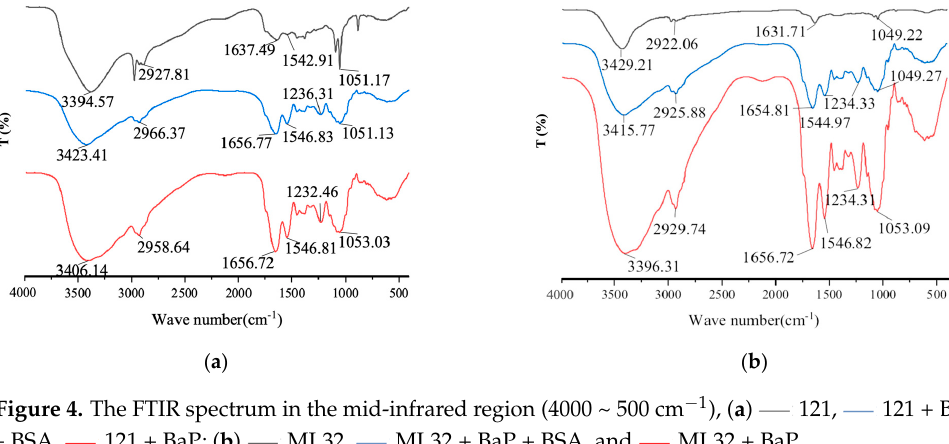
Figure 4. The FTIR spectrum in the mid-infrared region (4000 ~ 500 cm − 1 ), ( a ) 121, 121 + BaP + BSA, and 121 + BaP; ( b ) ML32, ML32 + BaP + BSA, and ML32 + BaP.